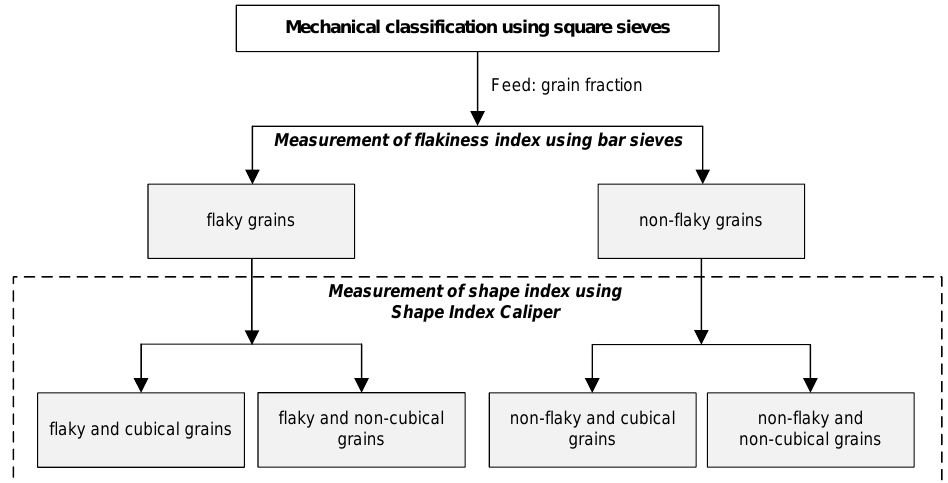
Figure 3. Grain classification scheme of samples before and after crushing.